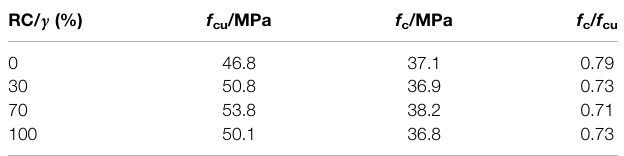
TABLE 4 | Measured strengths of RC.